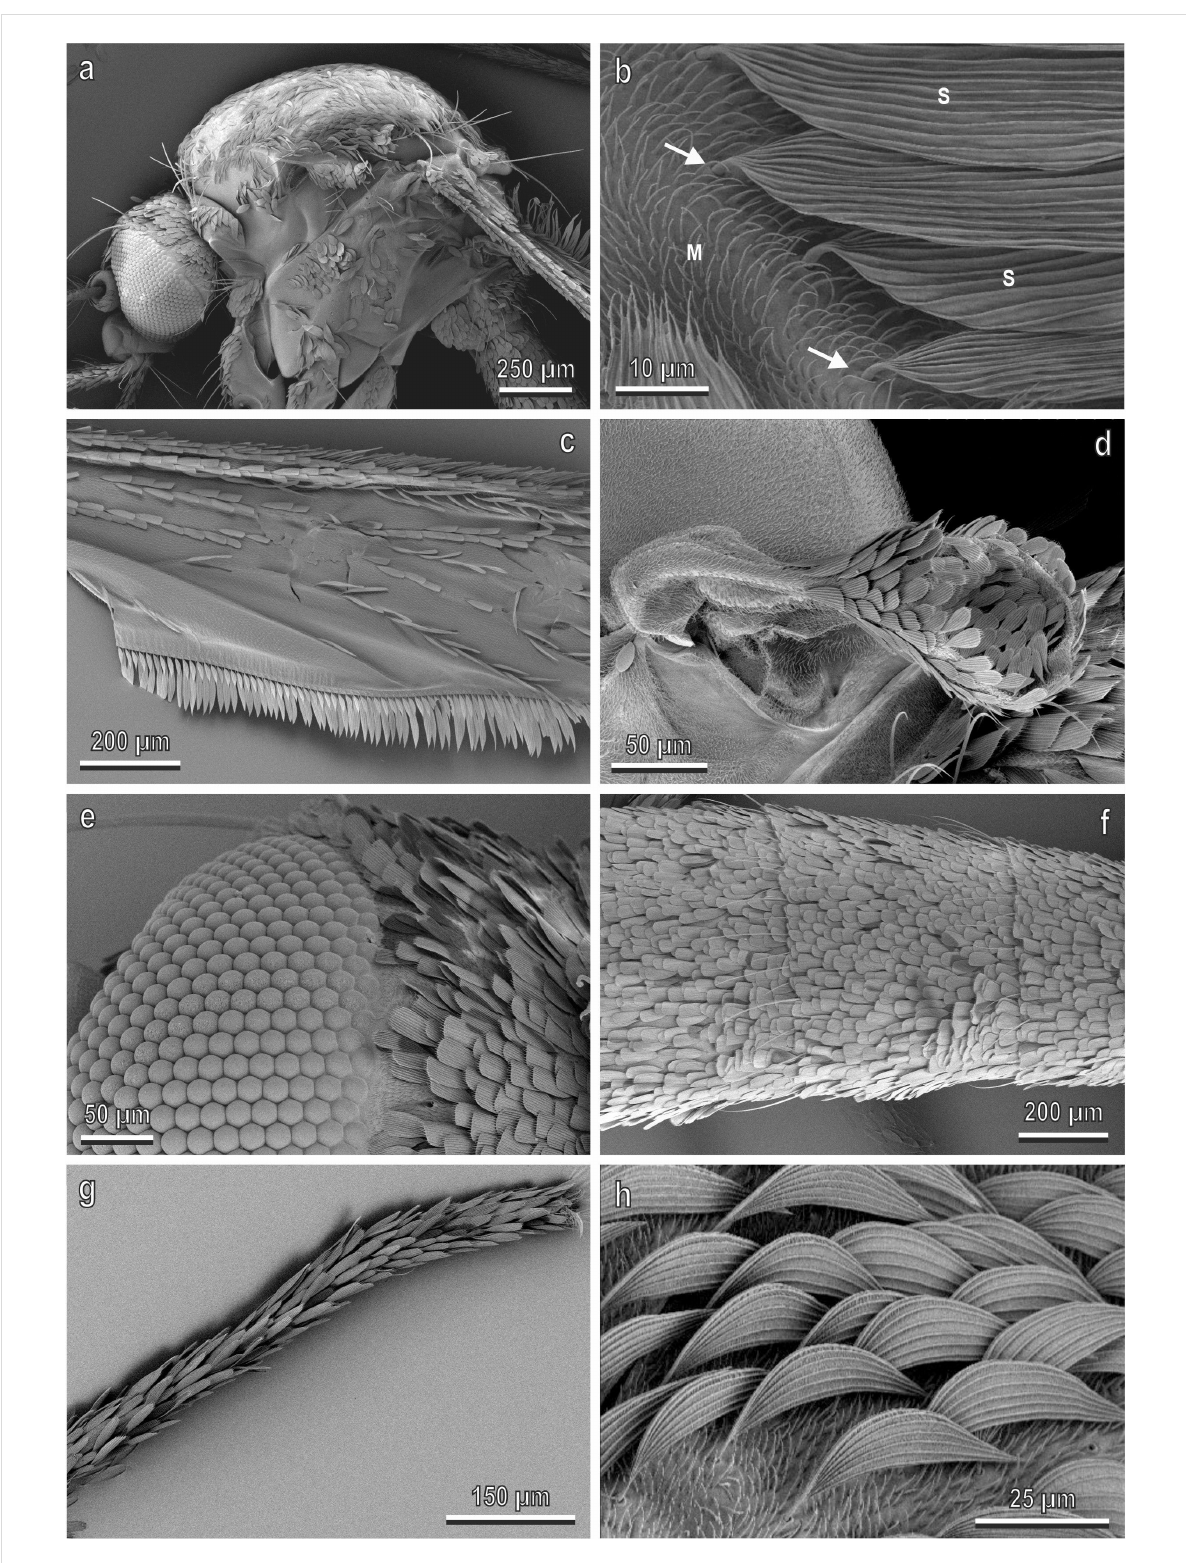
Figure 2: Aedes albopictus (female) in a cryo-SEM. (a) Lateral view of the thorax of Ae. albopictus covered with scales and microtrichia. (b) Detail of (a) showing microtrichia (M) and scales (S) with their articulated insertion (arrow) in the cuticle. (c–g) Scales with different shape located on the differ- ent body parts such as wings (c), halters (d), head (e), abdomen (f) and legs (g). (h) Detail of dorsal side of the thorax with falcate